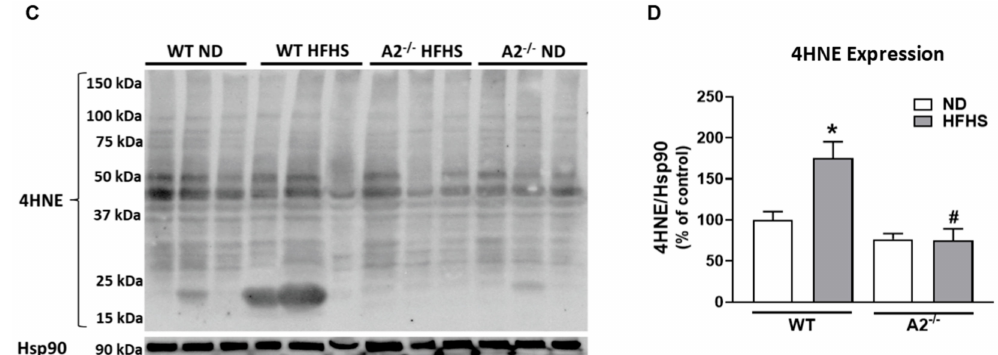
Figure 2. High-fat, high-sucrose (HFHS) diet increased retinal levels of tyrosine nitration and lipid peroxidation and this was prevented with arginase 2 (A2) deletion. Representative western blots and quantitation of 3-nitrotyrosine (3-NT) ( n = 3–4 per group) ( A , B ) from same membrane as Figure 1A and 4-hydroxynoneal (4HNE) ( n = 4 per group) ( C , D ) levels in retinas. Retinas from A2 − / − groups showed no elevation of 3-NT or 4HNE. Data are presented as mean ± SEM. * p < 0.05 compared to ND-fed mice of same genotype, # p < 0.05 compared to wild-type (WT) mice on same diet. 3.3. A2 Deletion Prevented HFHS-Induced Retinal Inflammation and Inflammasome Activation